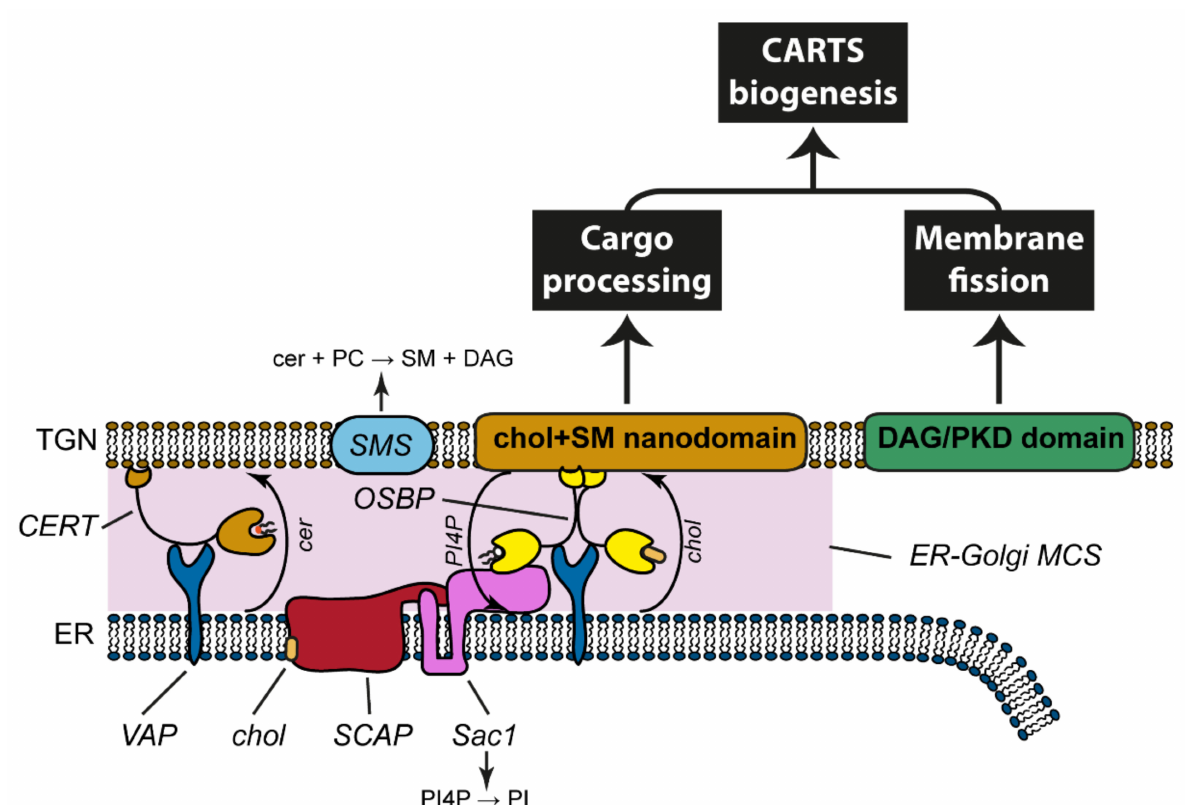
Figure 3. Lipid homeostasis at ER-Golgi MCSs for CARTS biogenesis. ER-Golgi MCSs serve as platforms for the non- vesicular transport of lipids and mediate the PI4P cycle at the ER-Golgi interface, as well as DAG, SM, and cholesterol homeostasis. cer: ceramide; chol: cholesterol; DAG: diacylglycerol; MCS: membrane contact site; PC: phosphatidylcholine; PI: phosphatidylinositol; PI4P: PI 4-phosphate; PKD: protein kinase D; SM: sphingomyelin; SMS: SM synthase. See text for